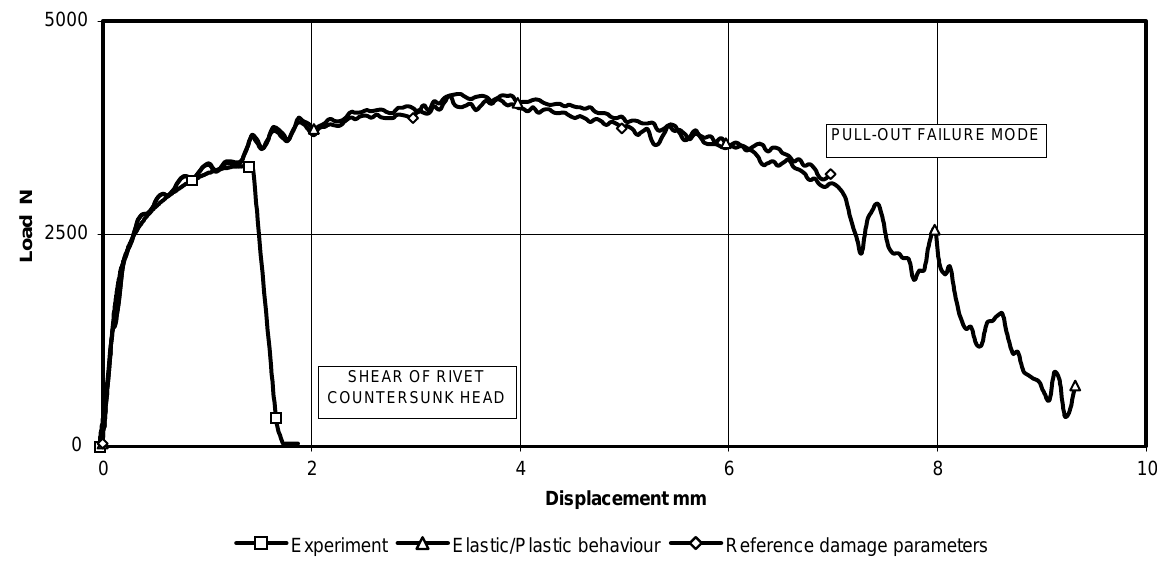
Fig. 12. Load vs. displacement diagram – Single lap riveted joint shear specimens.